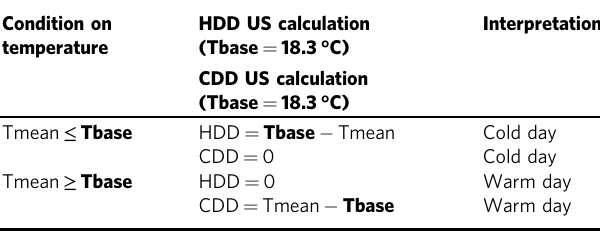
Table 2 Calculation of Heating Degree-Days (HDD) and Cooling Degree-Days (CDD) according to the US ASHREA for a day de fi ned with a daily mean (Tmean) surface air